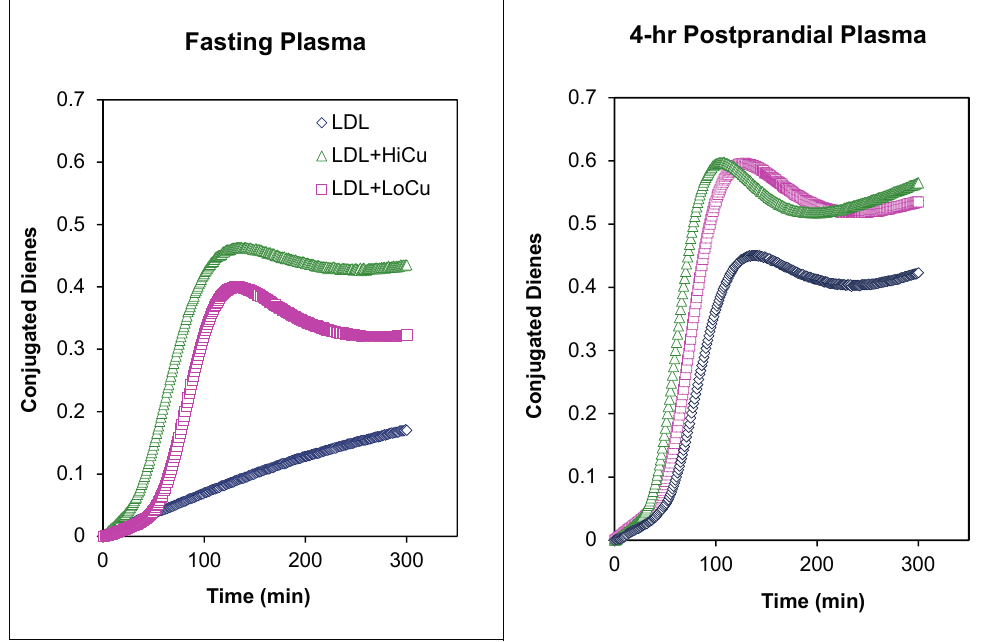
Figure 4. Meal-induced changes in oxidative susceptibility of LDL isolated from fasting versus LDL isolated from postprandial plasma of a patient with T2DM under dietary management. Blue symbols: LDL in the absence of Cu 2+ as catalyst. Green symbols: LDL in the presence of high Cu 2+ concentrations (9.0 mmol Cu 2+ per 45 mg of LDL-C). Pink symbols: LDL in the presence of low Cu 2+ concentrations (4.5 mmol Cu 2+ per 45 mg of